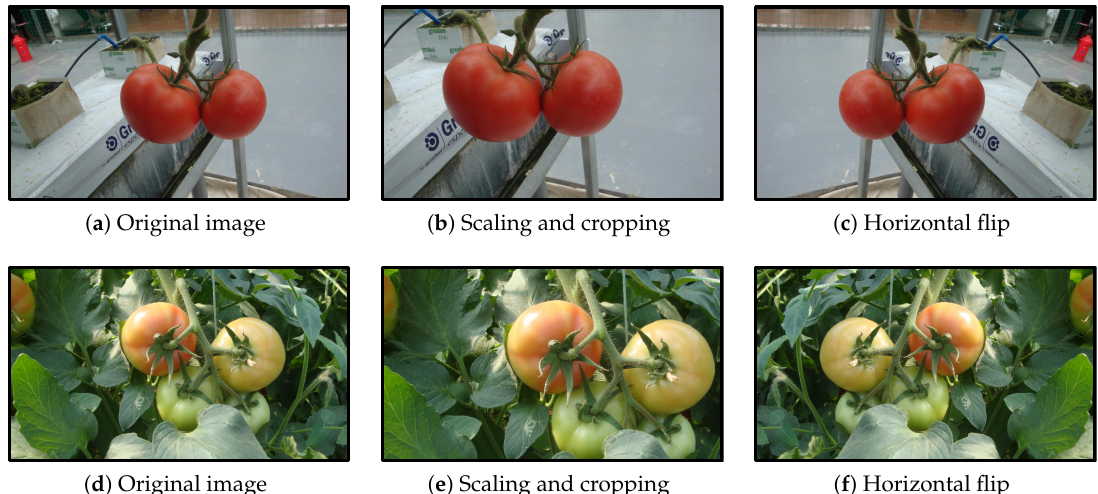
Figure 4. Some examples of image augmentation operations: ( left ): original images, ( middle ): scaling and cropping, and ( right ): horizontal